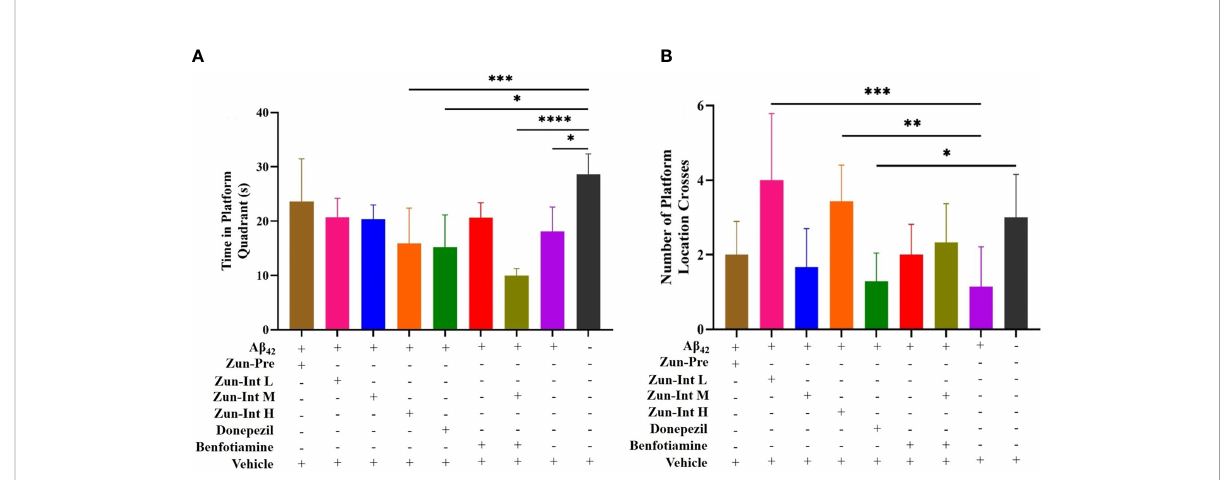
FIGURE 3 Effect of drug on the residence time in quadrant of the original platform and number of platform crossings. (A) Compared with AD model mice (Ab42), the residence time of the mice in the AD model group in the quadrant of the original platform was shorter than Vehicle group, the difference was statistically signi fi cant. Residence times of Zun-Int H group, donepezil group, and benfotiamine conjunction with Zun-Int M in the quadrant of the original platform were all lower than AD model group. Residence times of Zun-Pre group, Zun-Int L group, Zun-Int M group and benfotiamine intervention group longer than those in AD model group but no statistical signi fi cance. (B) Effect of drug on number of platform crossings. Compared with AD model mice, the platform crossing times of Zun-Int L group and Zun-Int H group were all higher than AD model model group and the difference was statistically signi fi cant.(n=7), *: P < 0.05; **: P < 0.01; ***: P < 0.001; ****: P <